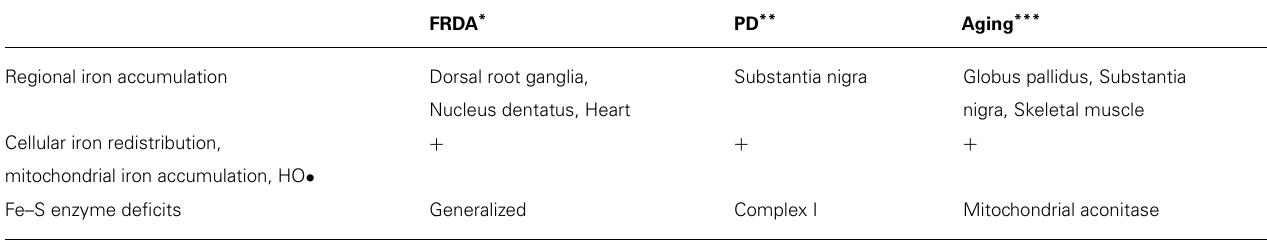
Table 1 | Indicators of mitochondrial Fe–S cluster dysfunction in FRDA, PD, and aging.